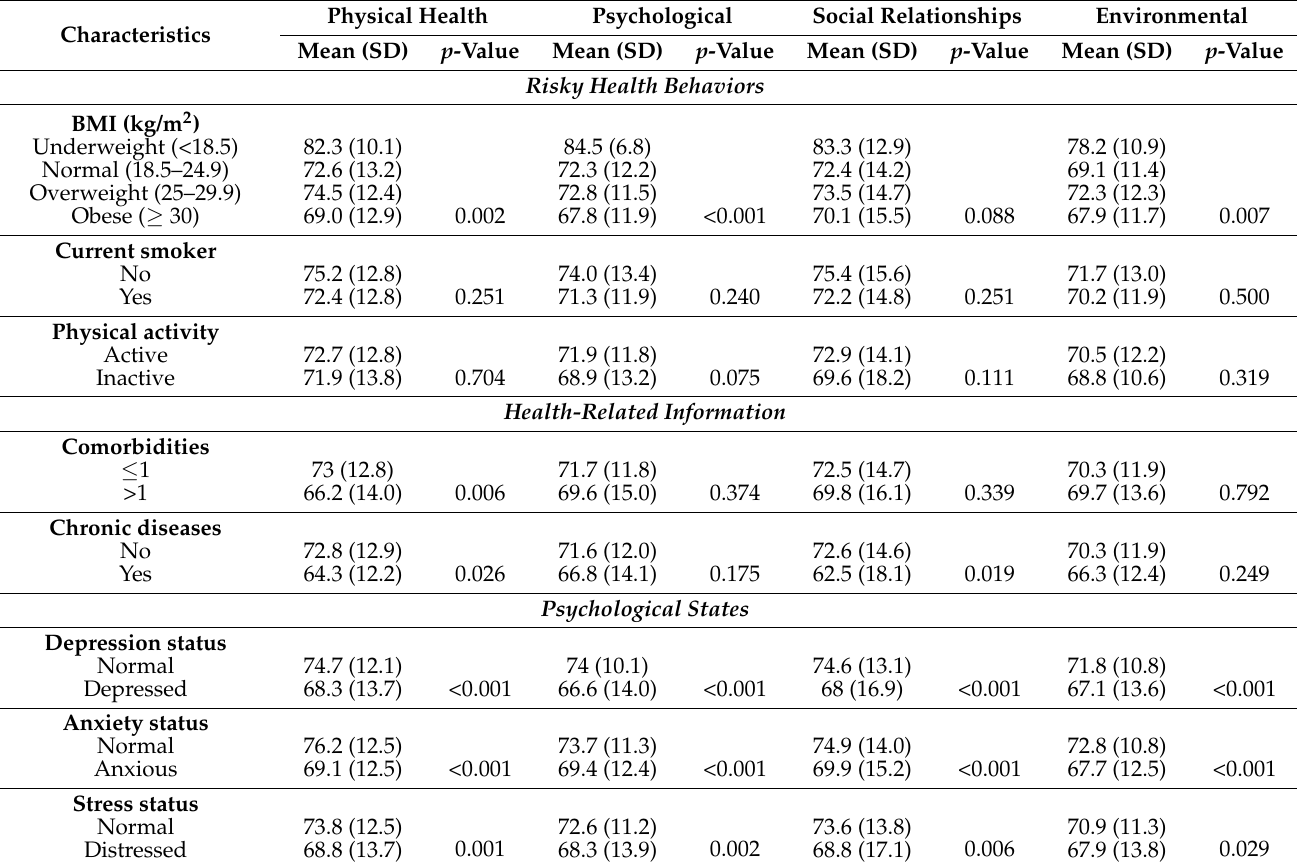
Table 3. Associations between HRQoL and risky health behaviors, health-related information, and psychological states. Physical Health Psychological Social Relationships Environmental Characteristics Mean (SD) p -Value Mean (SD) p -Value Mean (SD) p -Value Mean (SD) p -Value Risky Health Behaviors BMI (kg/m 2 ) Underweight